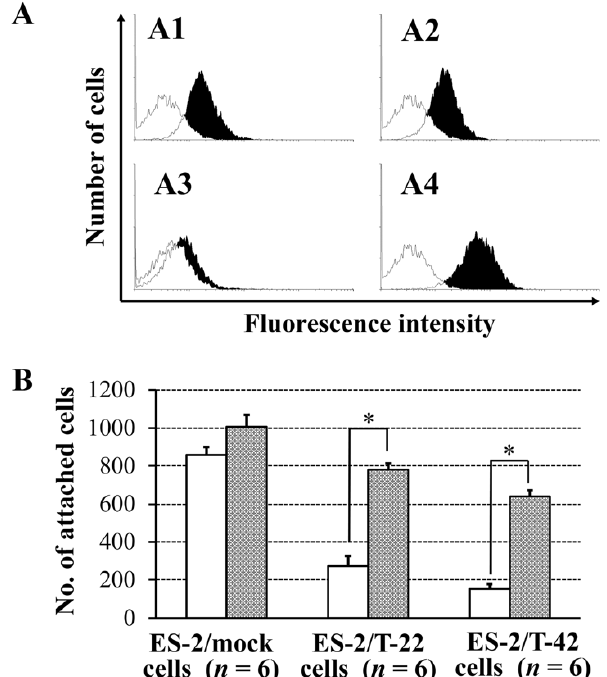
Figure 5. Effect of sialic acids expressed on the surface of peritoneal mesothelial cells on the binding of MUC1 transfected ovarian cancer cells. ( A ) Bindings of lectins specific for sialylated carbohydrate chains and antibodies specific for sialylated epitopes of MUC1 to the cell surfaces of peritoneal mesothelial cells derived from ovarian cancer patients. ( A1 ) Maackia amurensis leucoagglutinin (specific for α 2,3-linked sialic acid), ( A2 ) Sambucus sieboldiana agglutinin (specific for α 2,6-linked sialic acid), ( A3 ) mAb KM93 (specific for sialyl Lewis X), and ( A4 ) mAb MY.1E12 (specific for sialyl-T MUC1). Flow cytometric analysis. No shading: negative control (secondary antibody only); black shading: antibody/lectin bound cells. ( B ) Effect of sialidase treatment of mesothelial cells on the adhesion of ES-2/mock, ES-2/T-22, and ES-2/T-42 cells to the peritoneal mesothelial cell layer. Data shown are mean ± SEM. Mann-Whitney U-test. * p <